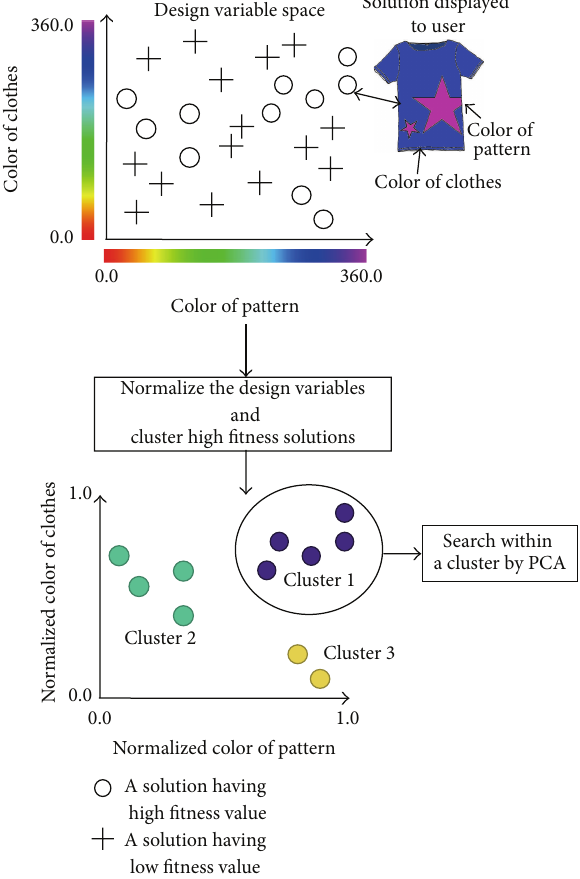
Figure 4: Example of results obtained when applying a clustering method to T-shirts